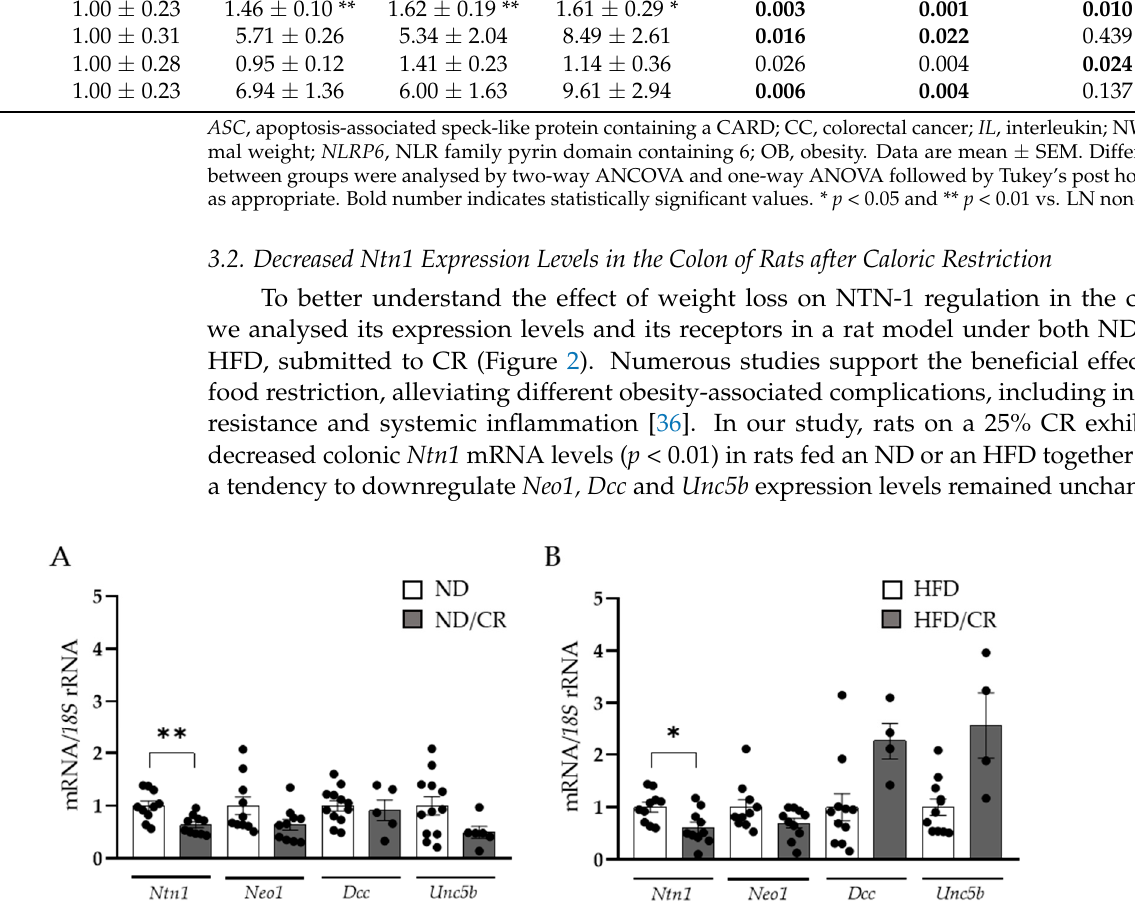
Figure 3. Gene expression levels of neogenin-1 ( NEO1 ), deleted in colorectal carcinomas ( DCC ) and uncoordinated-5 homolog family member B ( UNC5B ) in ( A ) HT-29 and ( B ) Caco-2 human colorectal cancer cell lines after the treatment with adipocyte conditioned media (ACM) for 24 h. Gene expression levels in untreated cells were assumed to be 1. Values are the mean ± SEM (n = 4–6 per group). Differences between groups were analysed by one-way ANOVA followed by Dunnett’s post hoc tests. * p < 0.05 and ** p < 0.01. Next, we studied the specific role of NTN-1, finding an upregulation of DCC in HT- 29 and Caco-2 cell lines (Figure 4A,B). The mRNA expression of NEO1 was increased ( p < 0.05) in HT-29 cells and gene expression levels of UNC5B remained unchanged in both colorectal cancer cell lines.